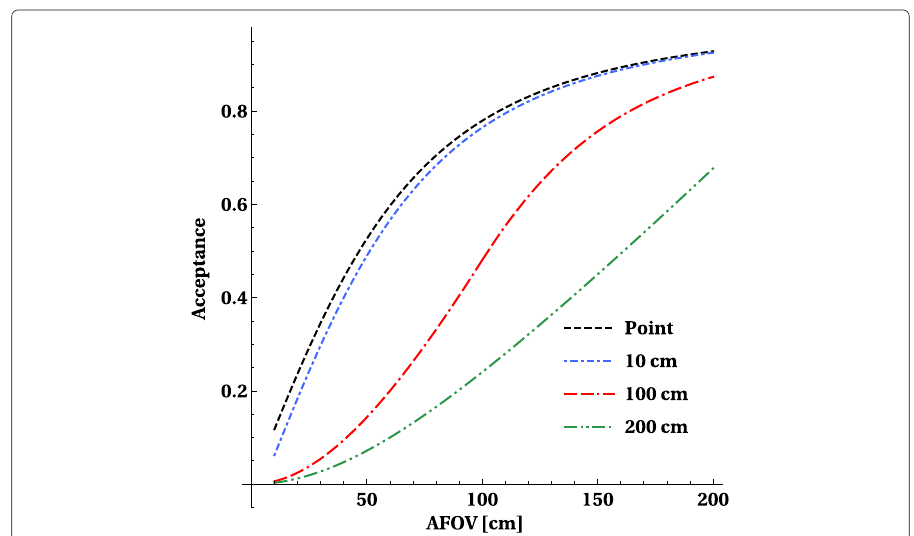
Fig. 3 The geometrical acceptance for a point-like source and line sources of 10 cm, 100 cm and 200 cm length in the transverse centre of a PET scanner with a diameter of 80 cm. The y -axis shows the fraction of the solid angle